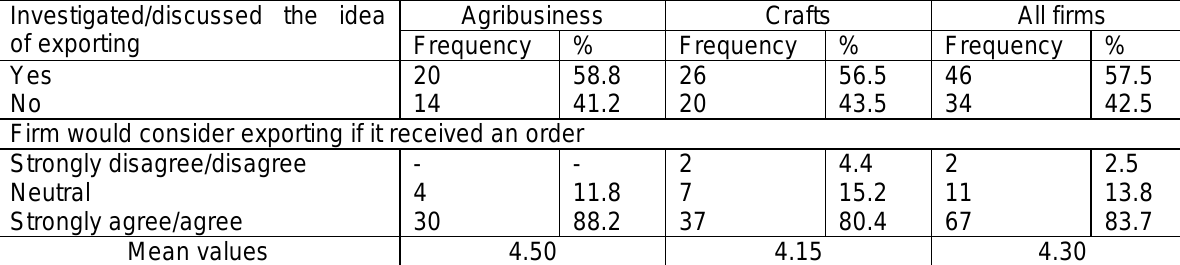
Table 1: Interest in